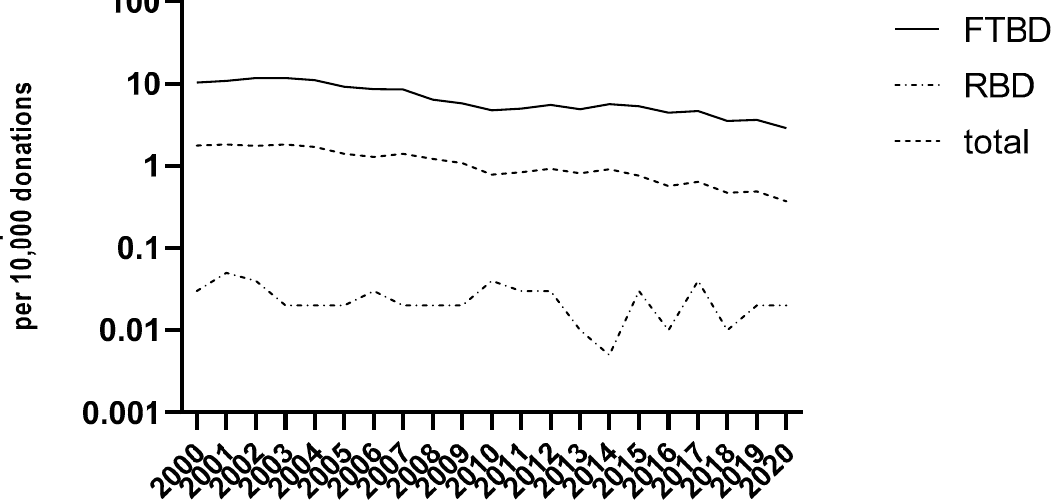
Figure 1. Rates of HBV positive donations (per 10,000) in France between 2000 and 2020 in total blood donor population and by donor status (FTBD: first time blood donors; RBD: repeat blood